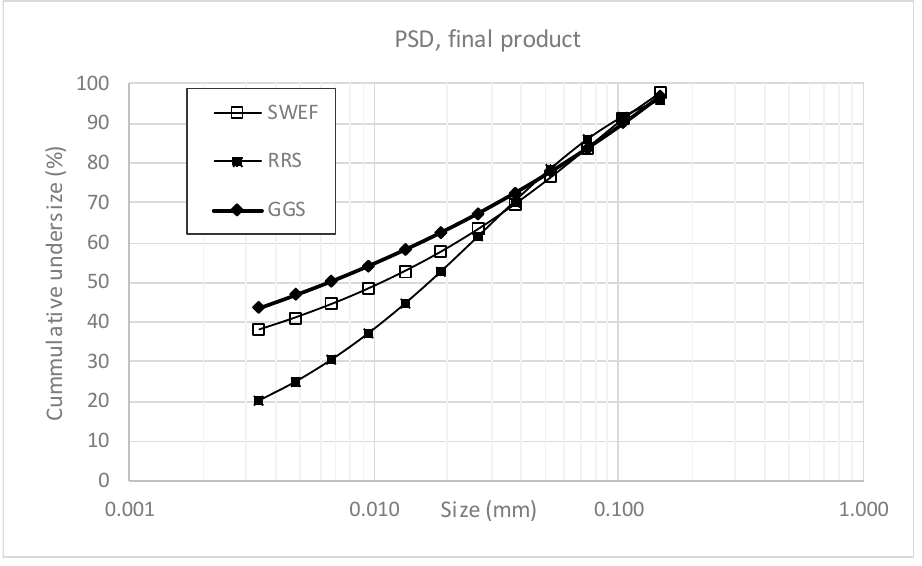
Figure 7. Distribution models fitted to the experimental data.